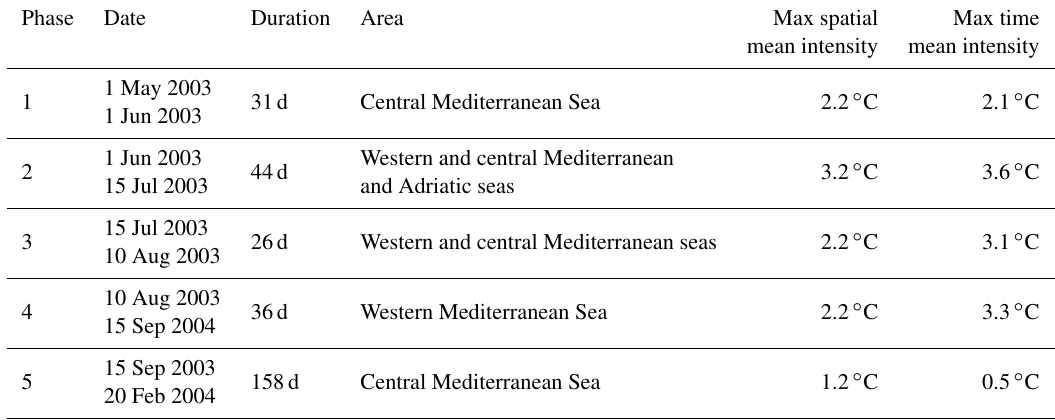
Table 1. Summary of the MED-MHW-2003